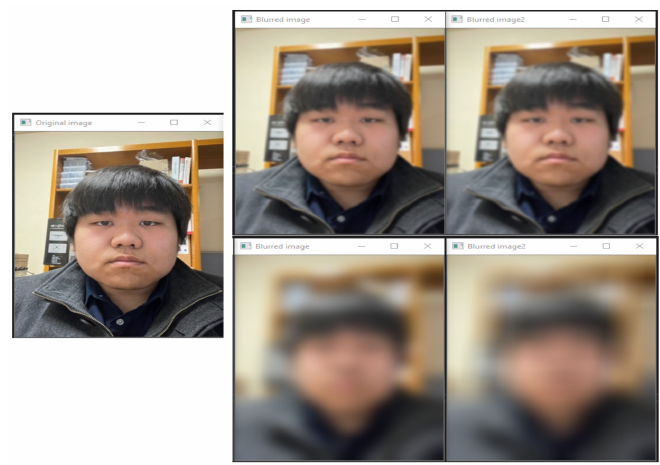
Figure 8. Original image information of the subject to be masked.